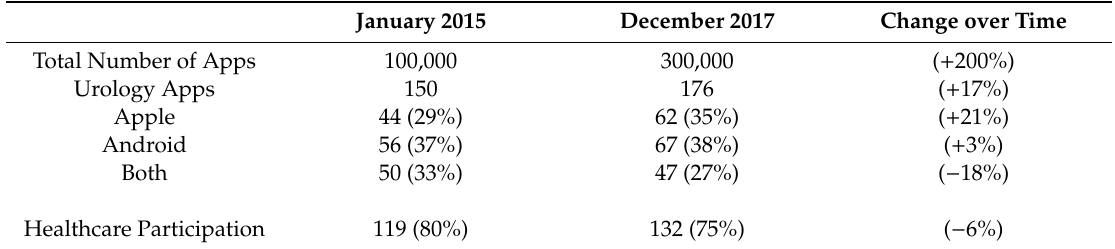
Table 1. Comparison of available apps between January 2015 and December